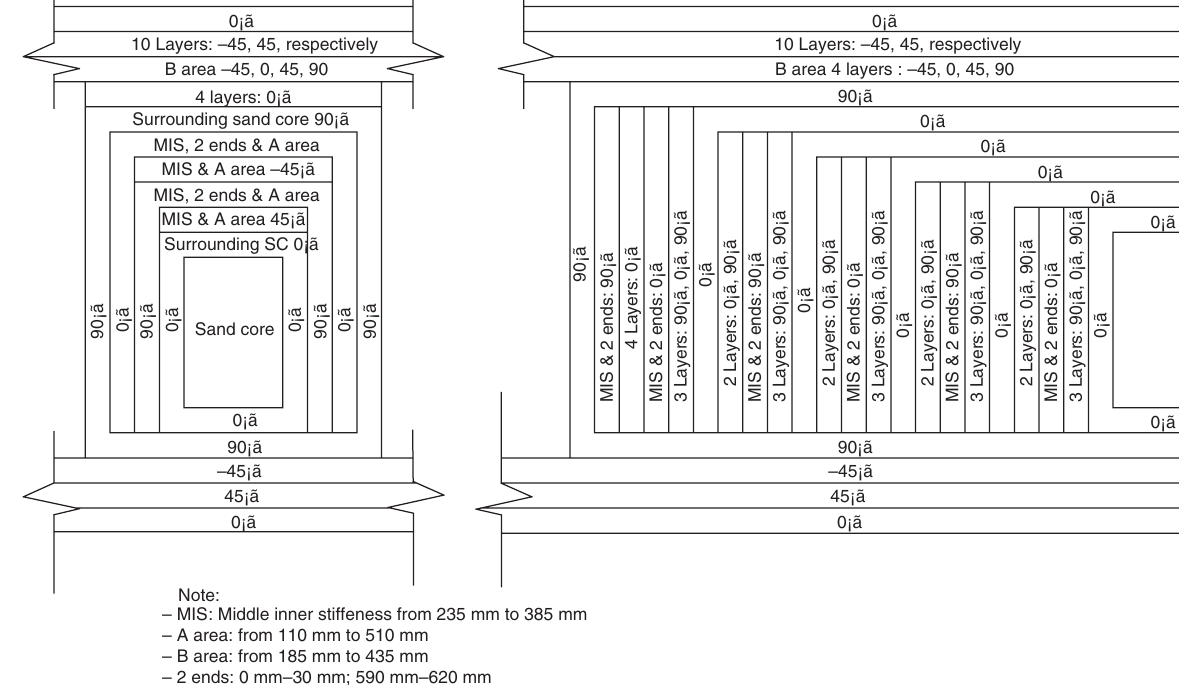
Figure 6: Detailed layer mode, location and amount of carbon fabric cloth in the box girder.